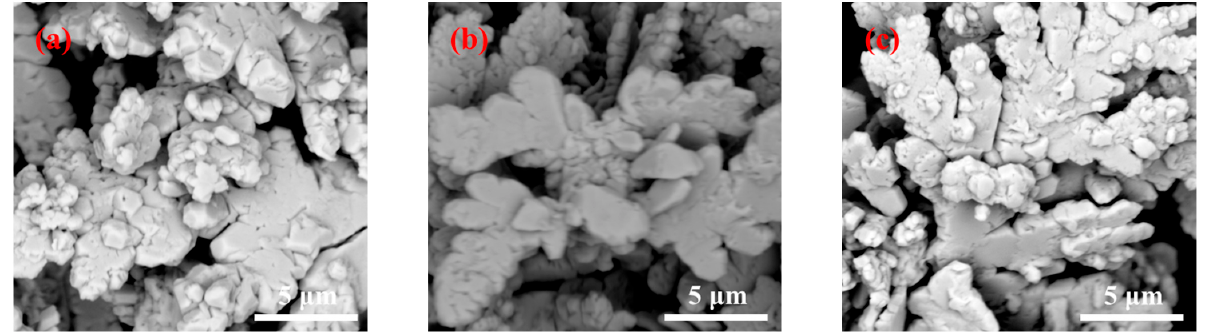
Figure 7. SEM images and particle size distribution of silver powders prepared under different flow rates by adding 2% gelatin. ( a ) 50 mL/min; ( b ) 75 mL/min; and ( c ) 100